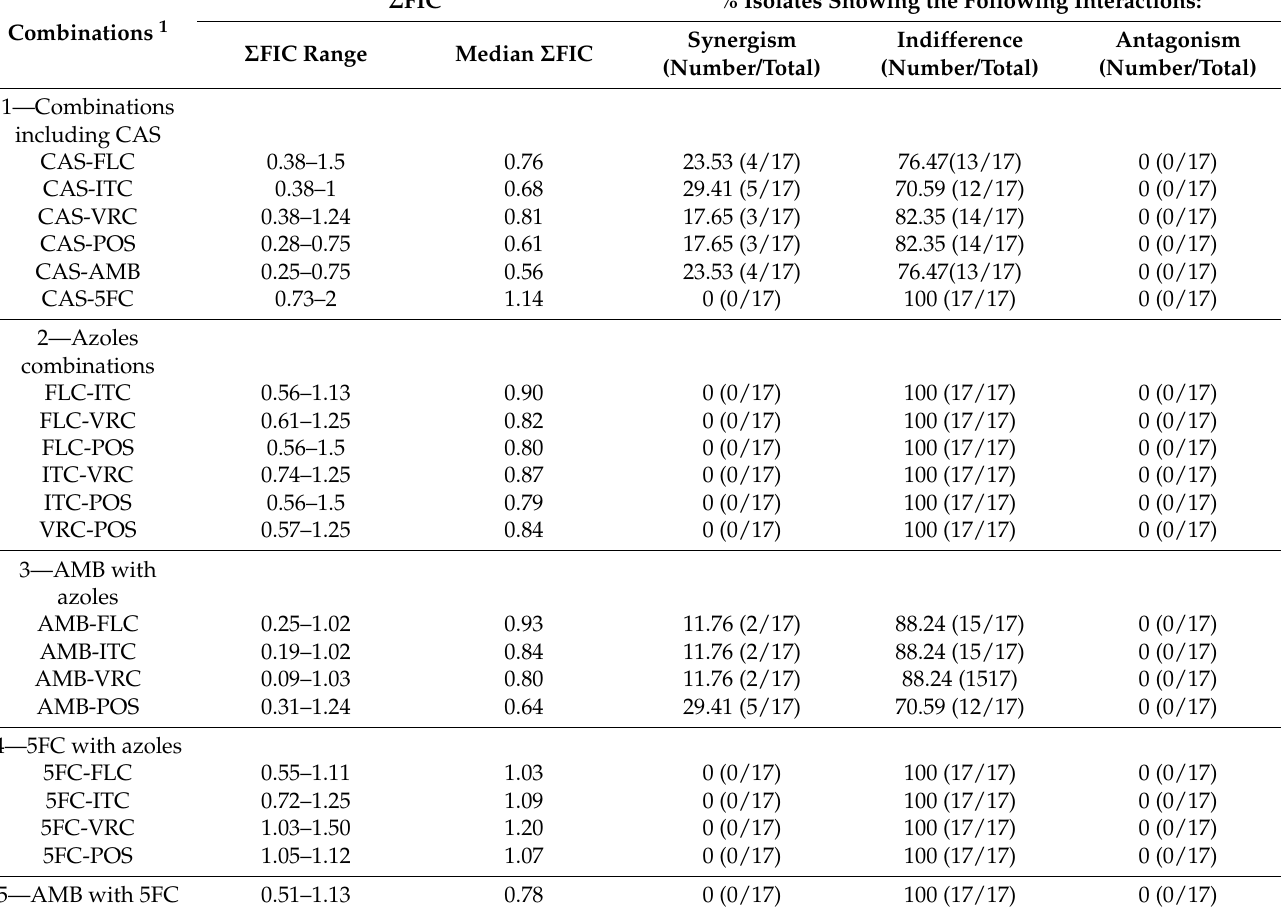
Table 3. In vitro activities of twenty-one antifungal combinations divided into five groups by checkerboard assay against 17 clinical isolates of Candida